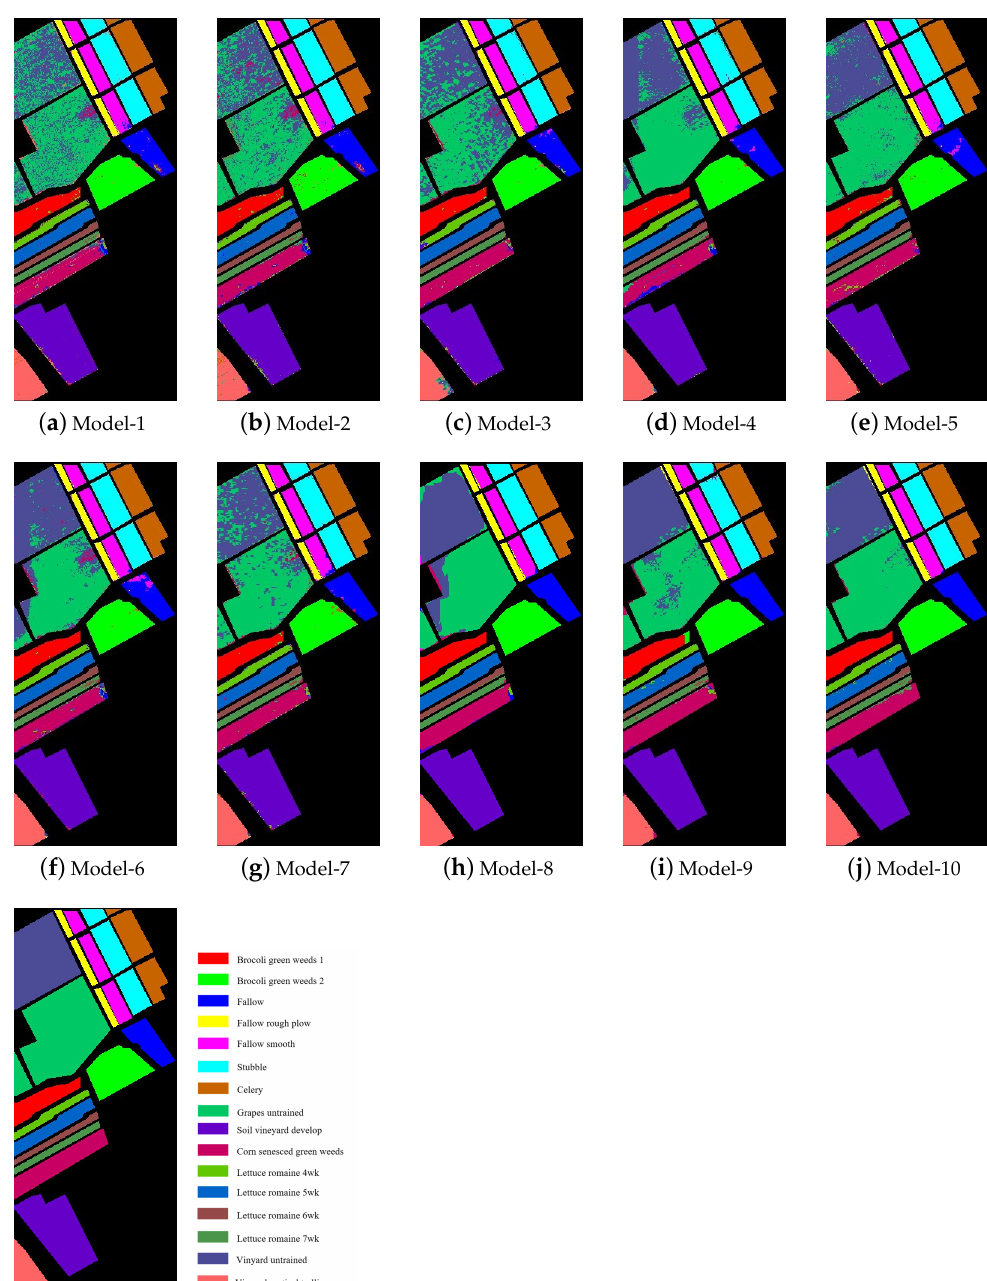
Figure 7. Classification maps of the models on the Salinas